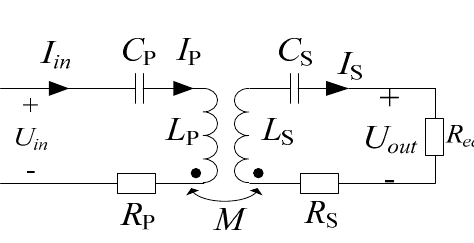
Figure 3. SS compensation equivalent circuit.